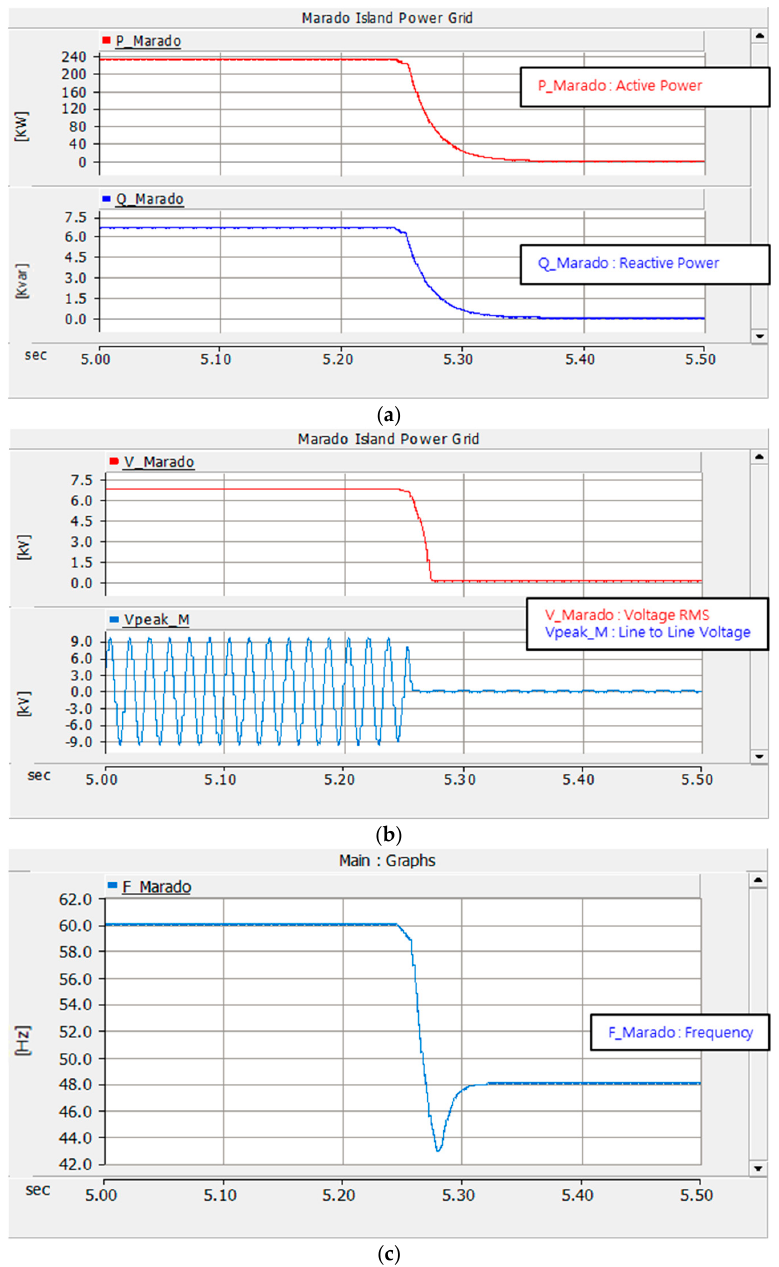
Figure 10. ( a ) Power; ( b ) voltage; ( c ) frequency; waveform in diesel generator